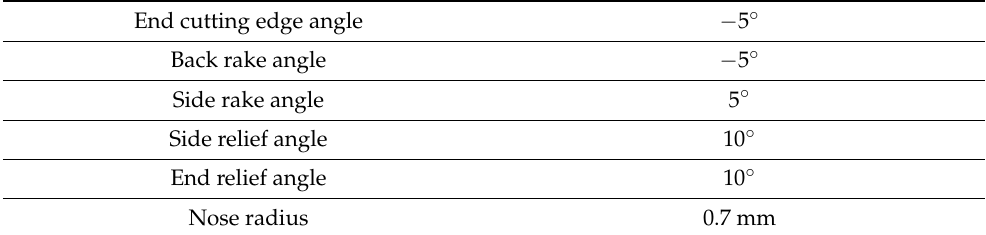
Table 2. Tool Nomenclature for CNMG turning tool holder.